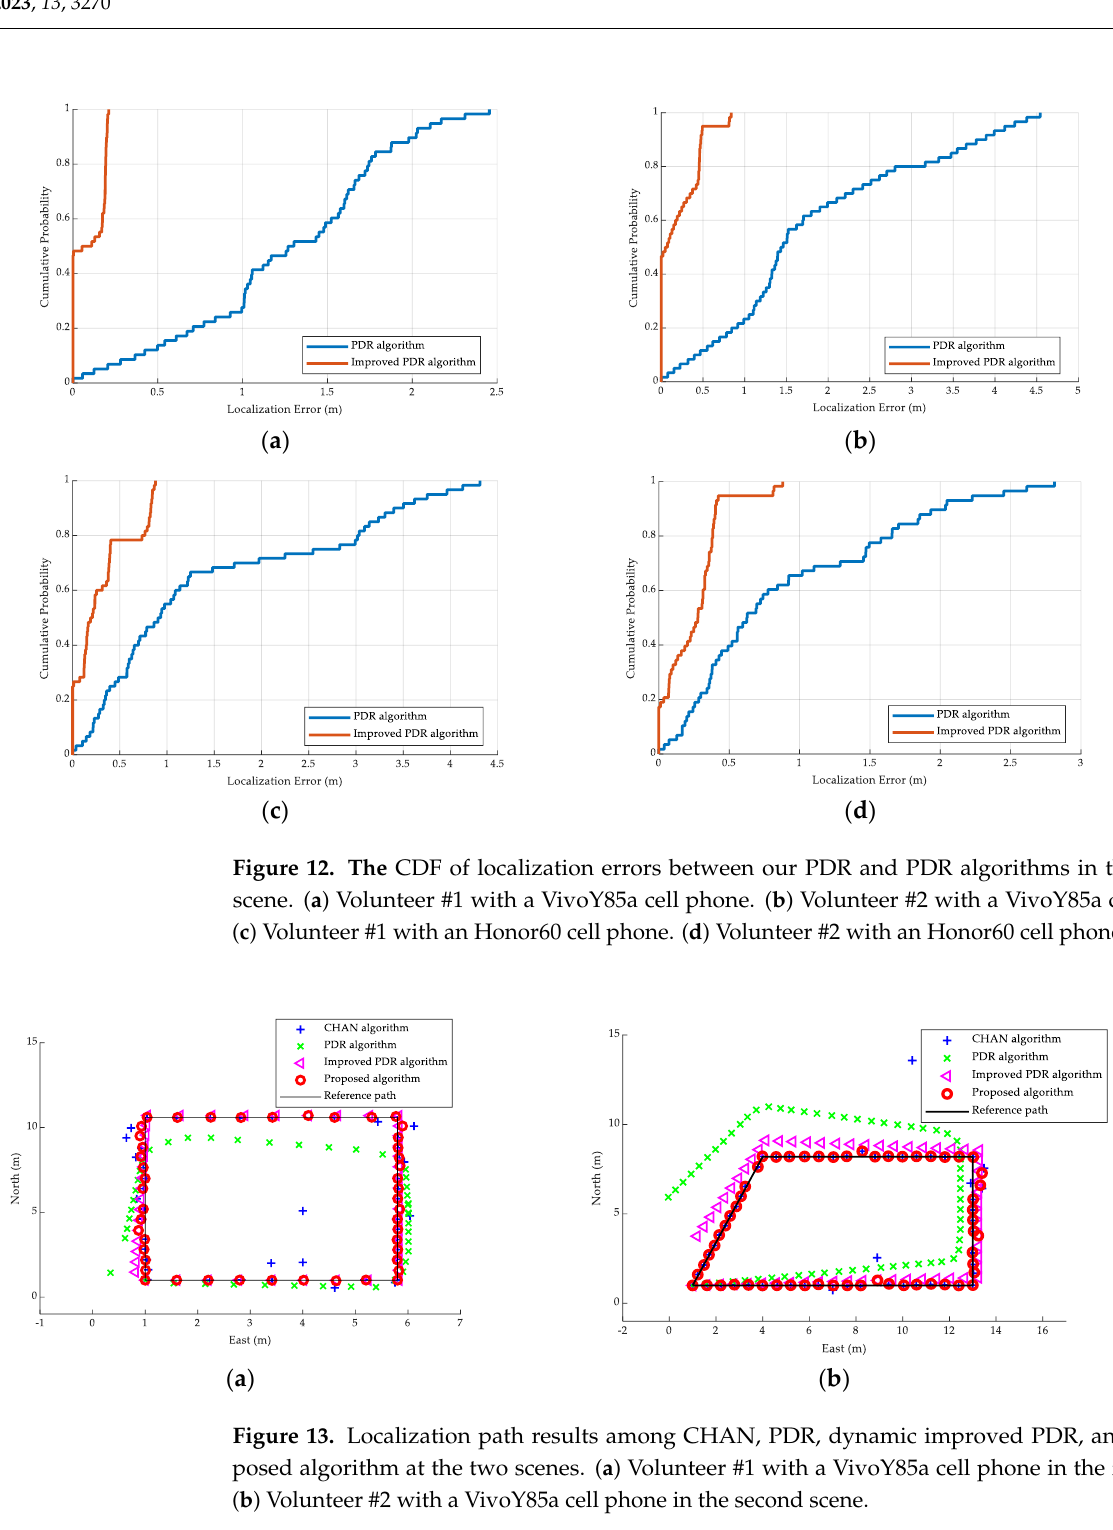
Figure 11. The CDF of localization errors between our PDR and PDR algorithms in the first scene. ( a ) Volunteer #1 with a VivoY85a cell phone. ( b ) Volunteer #2 with a VivoY85a cell phone. ( c ) Vol- unteer #1 with an Honor60 cell phone. ( d ) Volunteer #2 with an Honor60 cell phone.